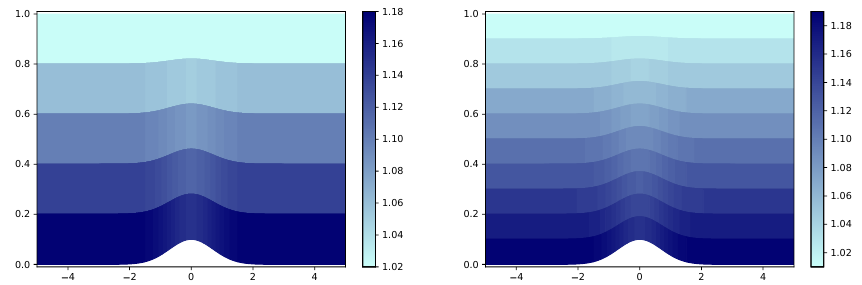
Figure 2. Solution of the ODE (12) for an stratified fluid with M = 5 ( left ) and M = 10 ( right ).